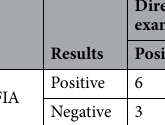
Table 2. Comparing LFIA and microscopic slide results.